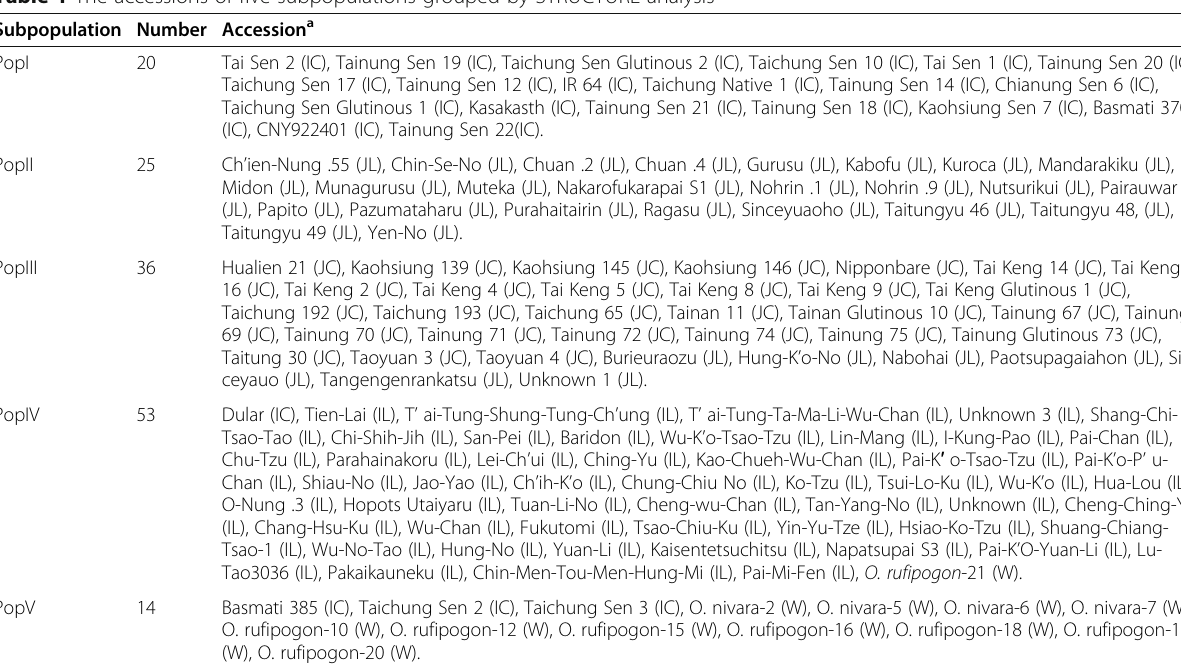
Table 1 The accessions of five subpopulations grouped by STRUCTURE analysis Subpopulation Number Accession